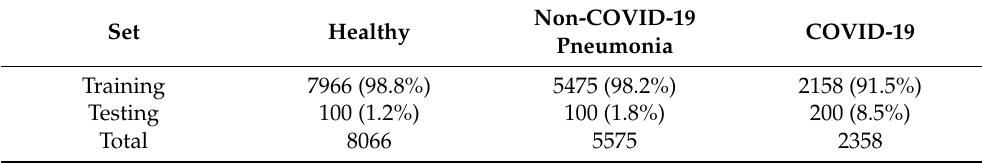
Table 4. COVIDx V8A dataset training and testing